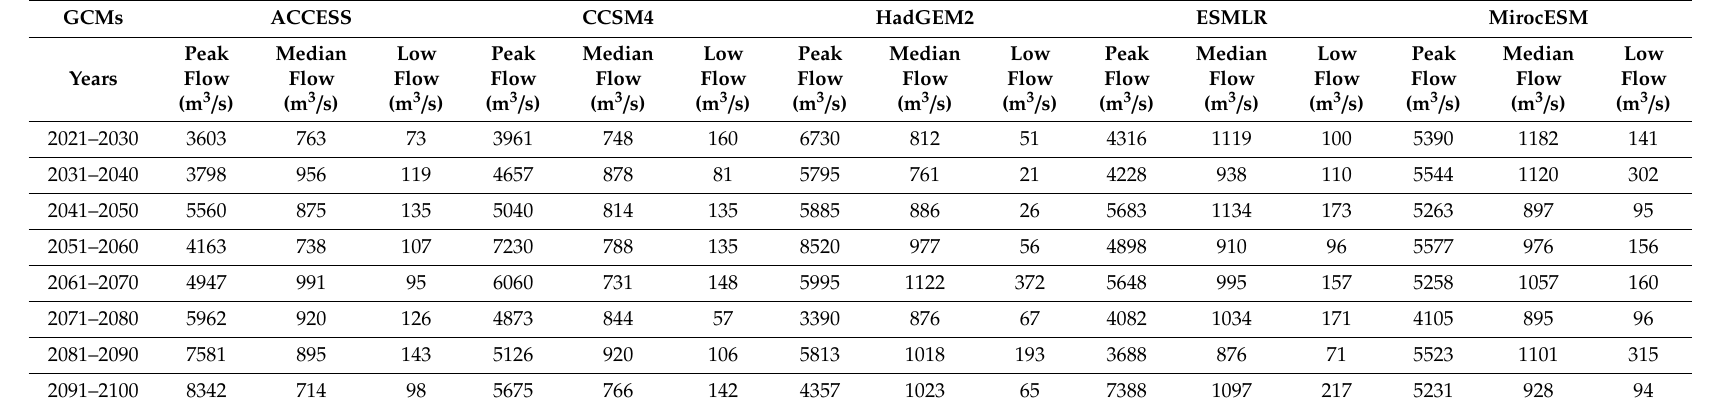
Table A1. Peak, median and low flows (2021–2100) under RCP-4.5.